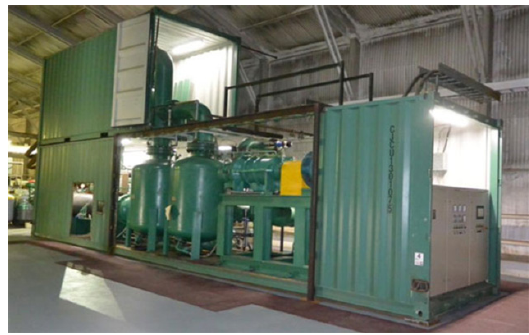
Figure 10. Alaska Chena hot spring geothermal generator set.